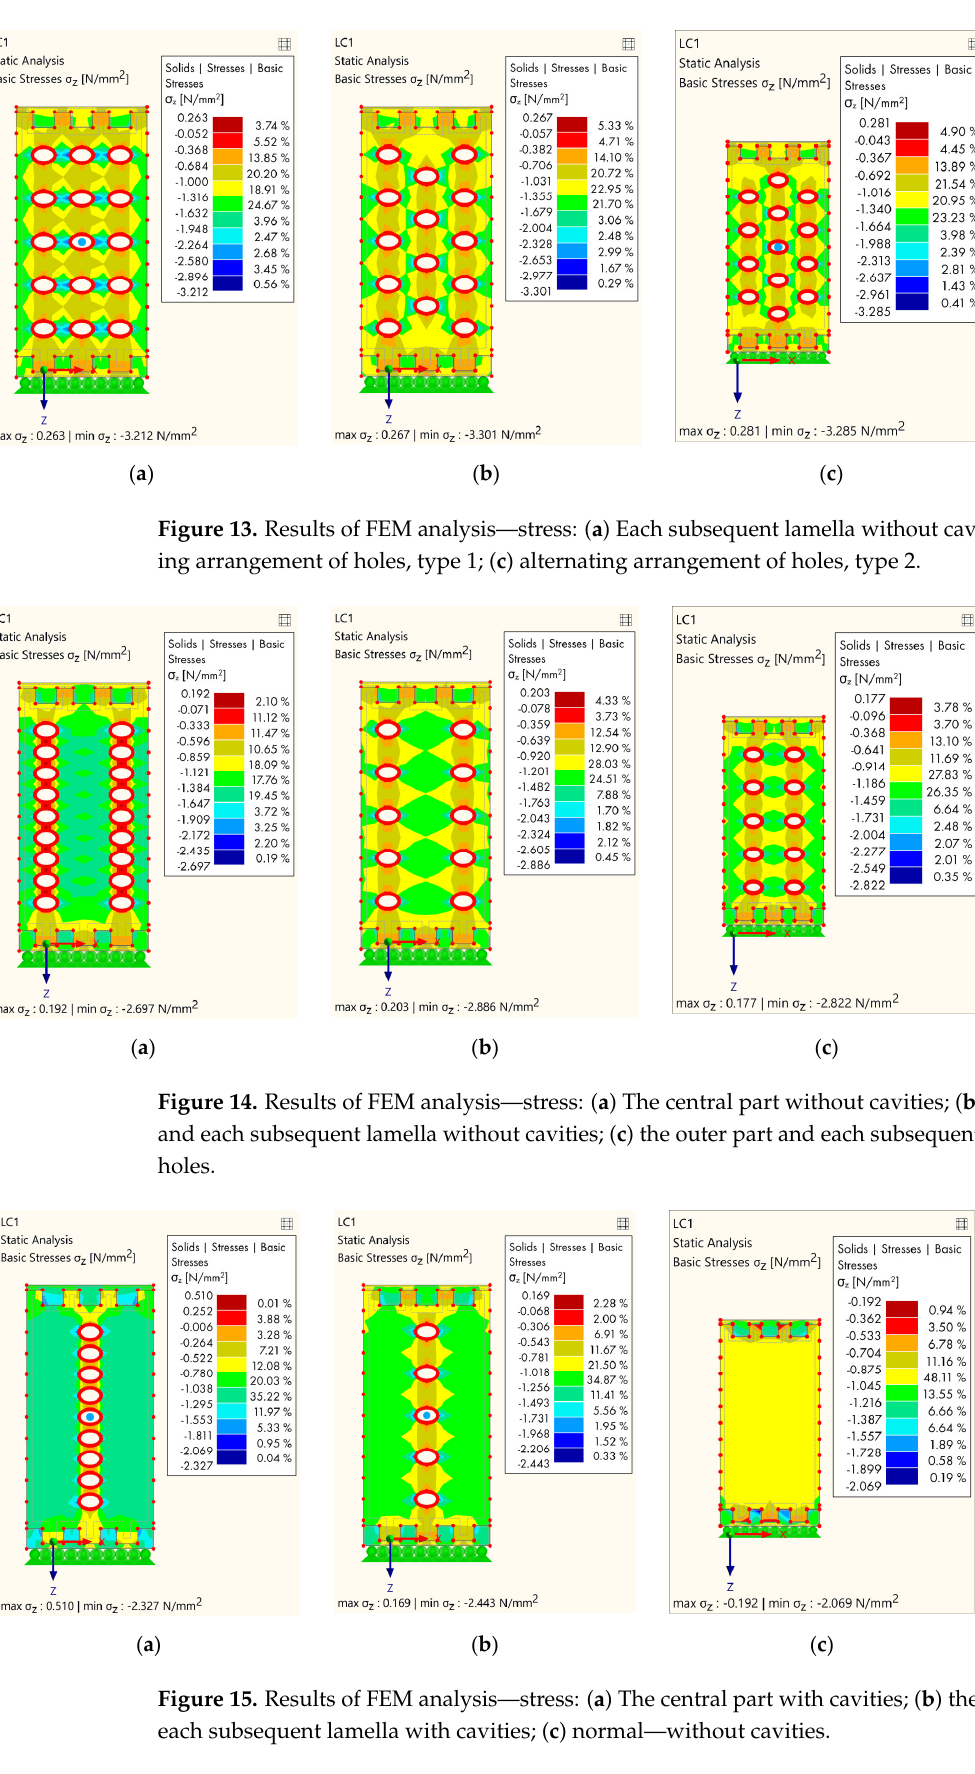
Figure 12. Results of FEM analysis—stress: ( a ) Completely perforated timber element; ( b ) the first lamella without cavities; ( c ) the second lamella without cavities. The next group of models (Figure 13) is reflected in the variability of the holes in alternating rows.